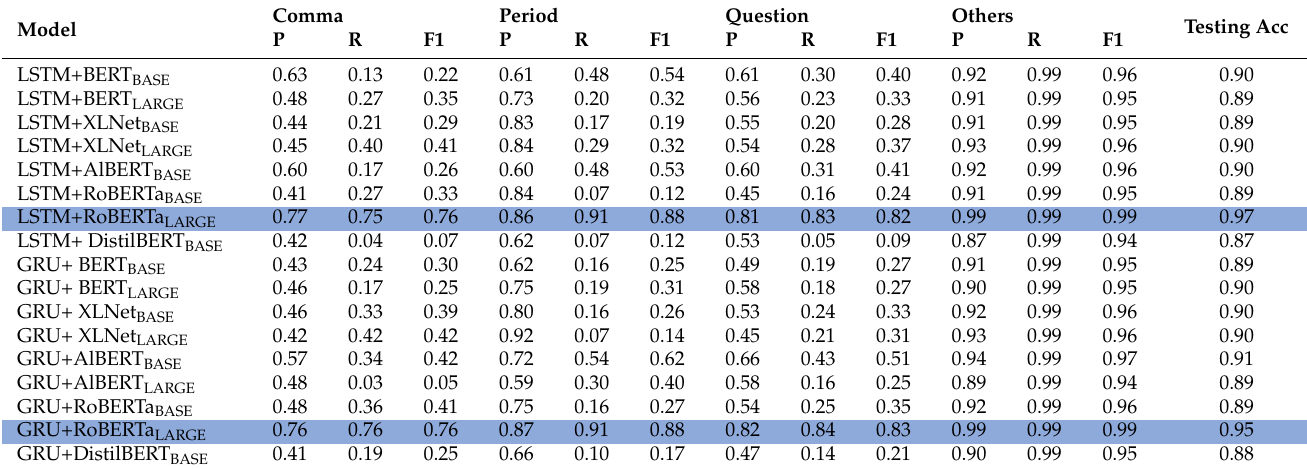
Table 7. Test experimental results (Amazon reviews).